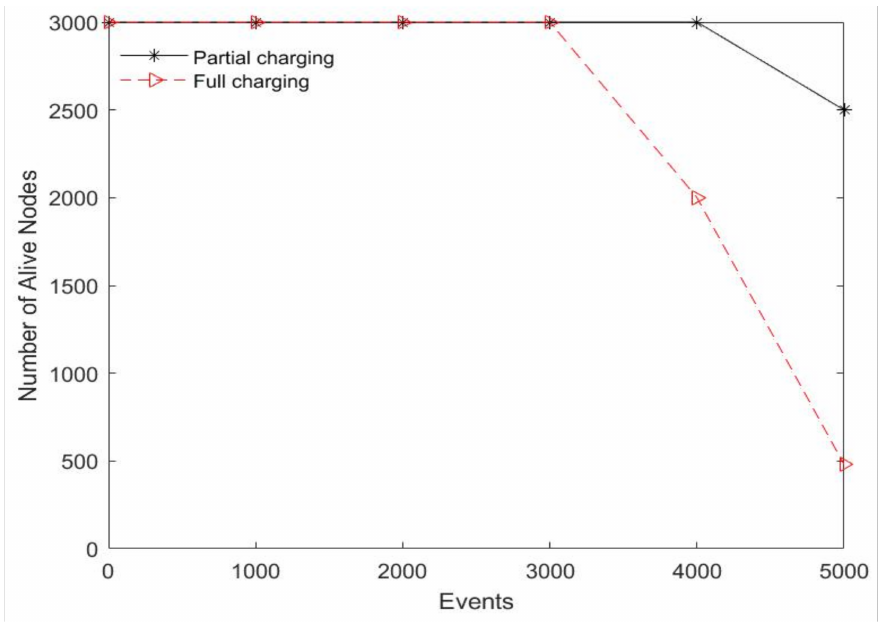
Figure 6. Number of alive nodes for full and partial charging with 40% of total energy.